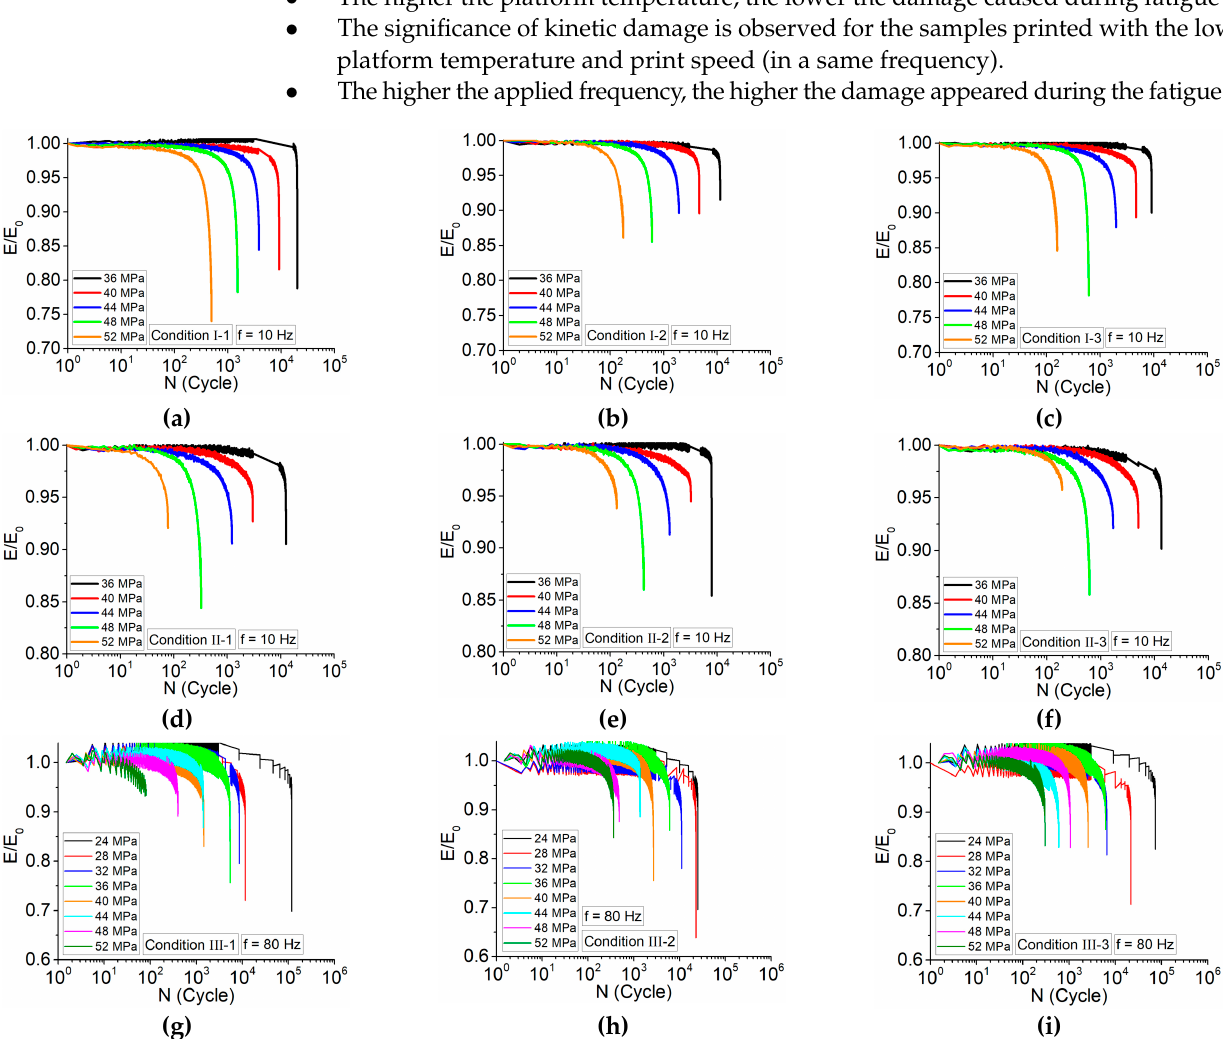
Figure 9. Evolution of the relative Young’s modulus (E/E 0 ) during tension–tension fatigue tests: ( a ) condition I-1; ( b ) condi- tion I-2, ( c ) condition I-3 at frequency of 10 Hz, ( d ) condition II-1, ( e ) condition II-2, ( f ) condition II-3 at frequency of 10 Hz, ( g ) condition III-1, ( h ) condition III-2, and ( i ) condition III-3 at frequency of 80